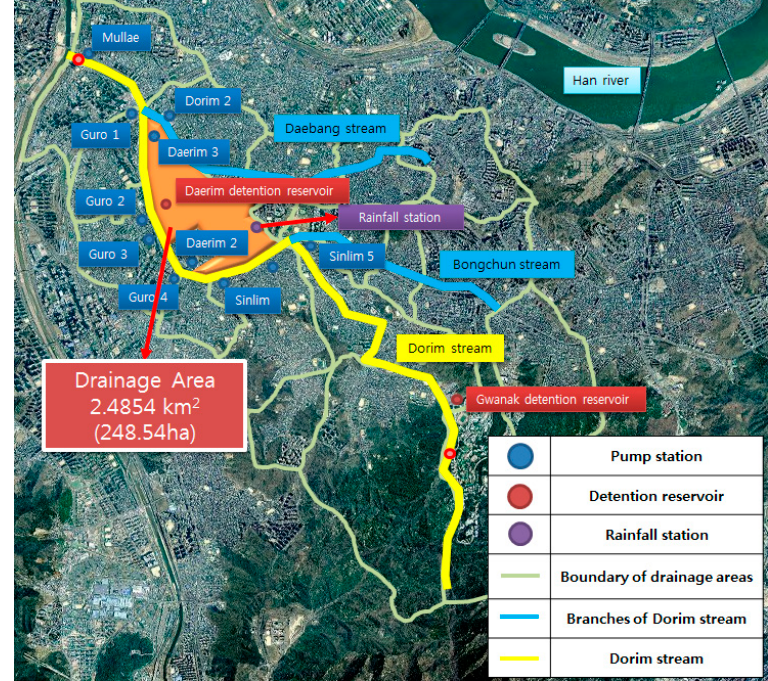
Figure 9. Dorim stream study area (from Google Earth Imagery © Google Inc., 2015).